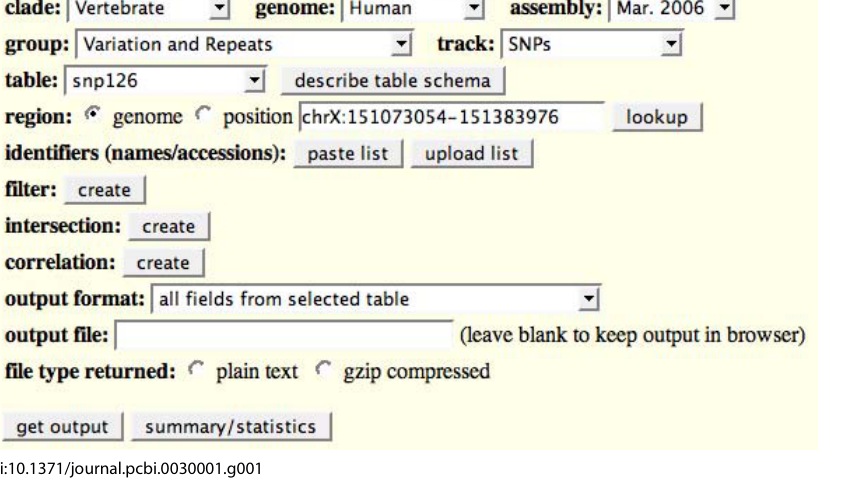
Figure 1. Table Browser Interface As shown in the screenshot, from the Table Browser Interface, one can select essentially any table in the UCSC Genome Database and obtain descriptions of the table’s fields as well as download all or part of the table’s records in a variety of